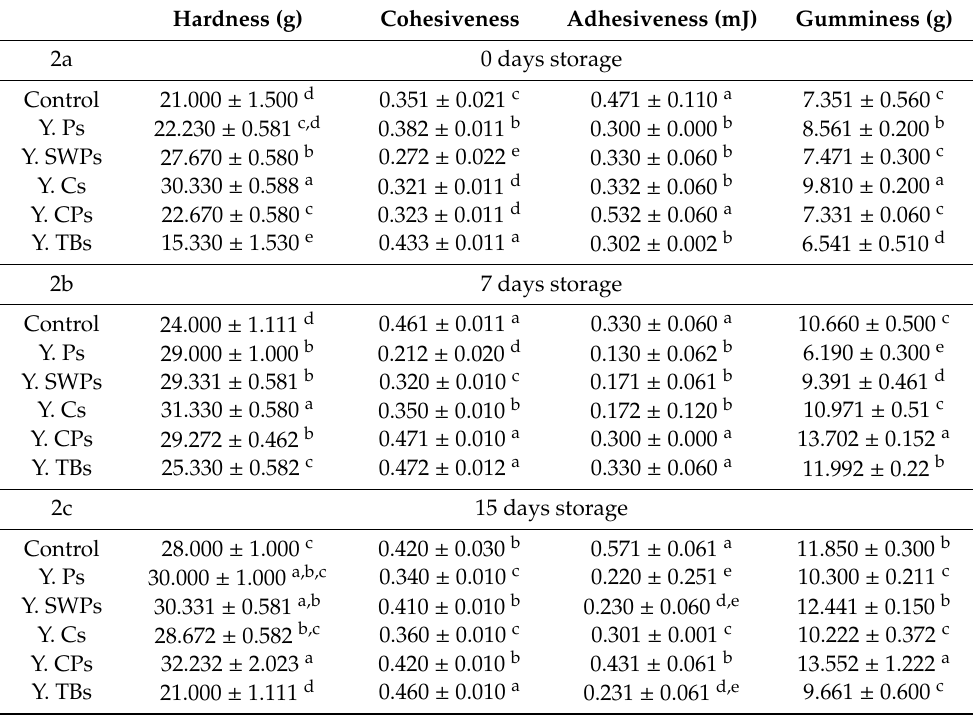
Table 2. E ff ect of starches addition on texture of yogurt after 0, 7, and 15 days of storage. Hardness